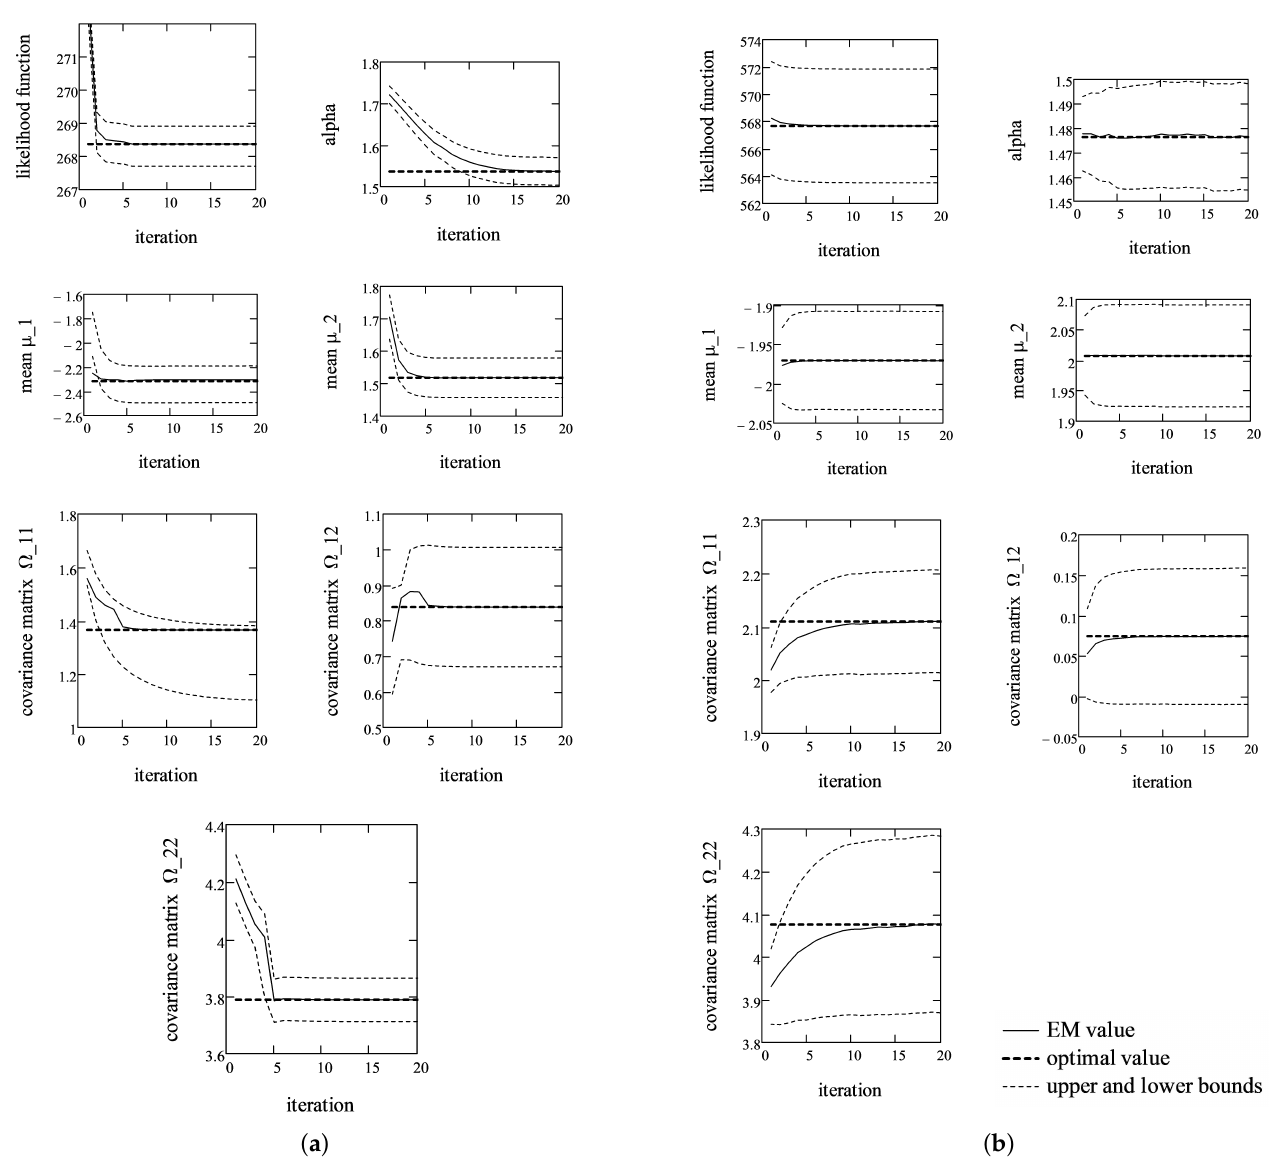
Figure 1. Average log-likelihood function (LLF) and average estimates of parameters µ , Ω , α in the case of d = 2: K = 50 ( a ); and K = 100 ( b